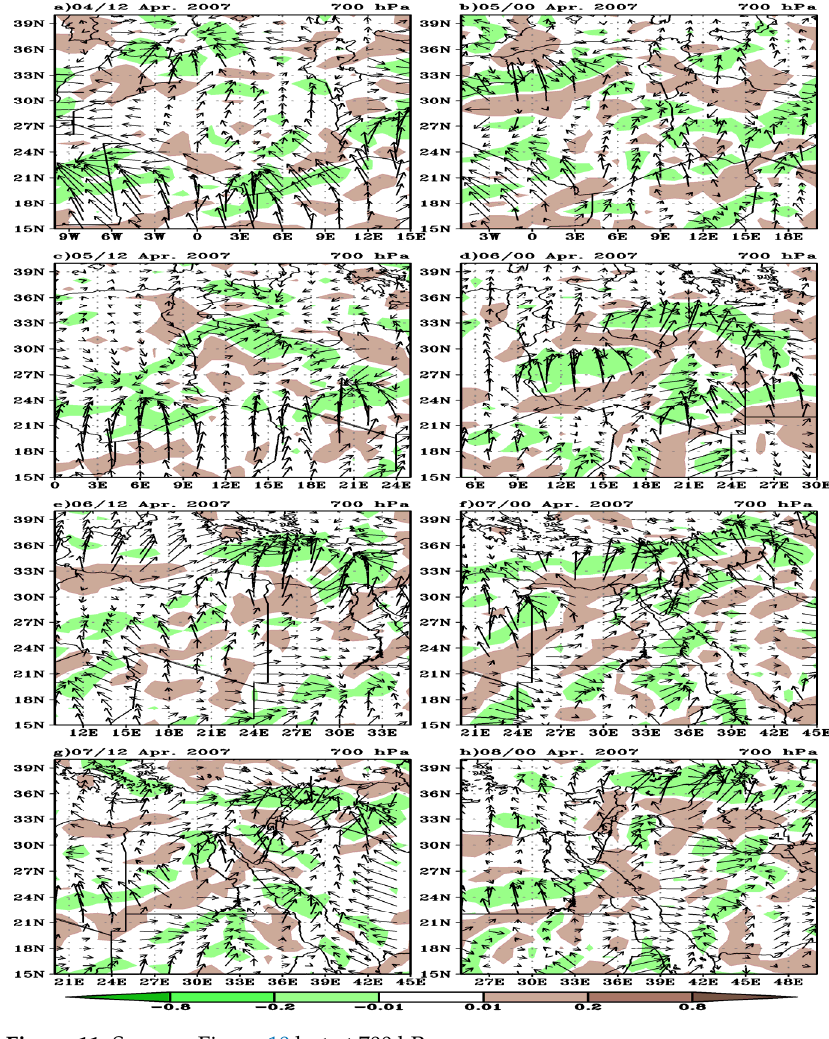
Figure 11. Same as Figure 10 but at 700